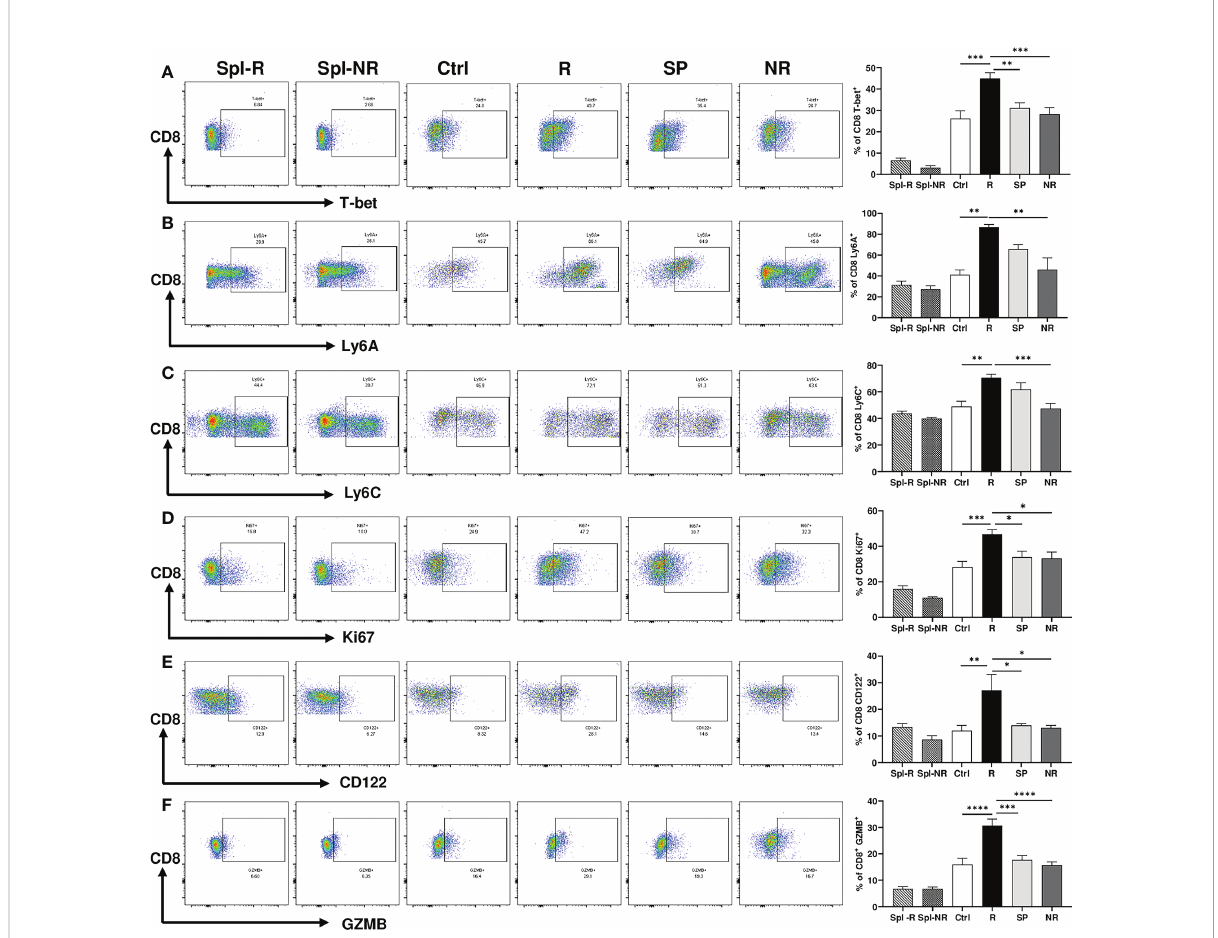
FIGURE 7 Activation markers differentially expressed between responder (R) and non-responder (NR) CD8 TILs. (A – F) Representative fl ow plots and percentages of CD8 T cells expressing T-bet (A) , Ly6A (B) , Ly6C (C) , Ki67 (D) , CD122 (E) , GZMB (F) in spleens from R (Spl-R) or NR (Spl-NR) mice, or in tumors from control (Ctrl) or anti-PD-L1 treated recipients including R, slow progressors (SP), and NR. Data were presented as mean ± SEM (Spl-R: n=10; Spl-NR: n=12; Ctrl: n=7; R: n=10; SP: n=8; and NR: n=12). Statistical signi fi cance was calculated with one-way ANOVA followed by Tukey ’ s multiple comparisons test (* P <0.05; ** P <0.01; *** P <0.001; **** P